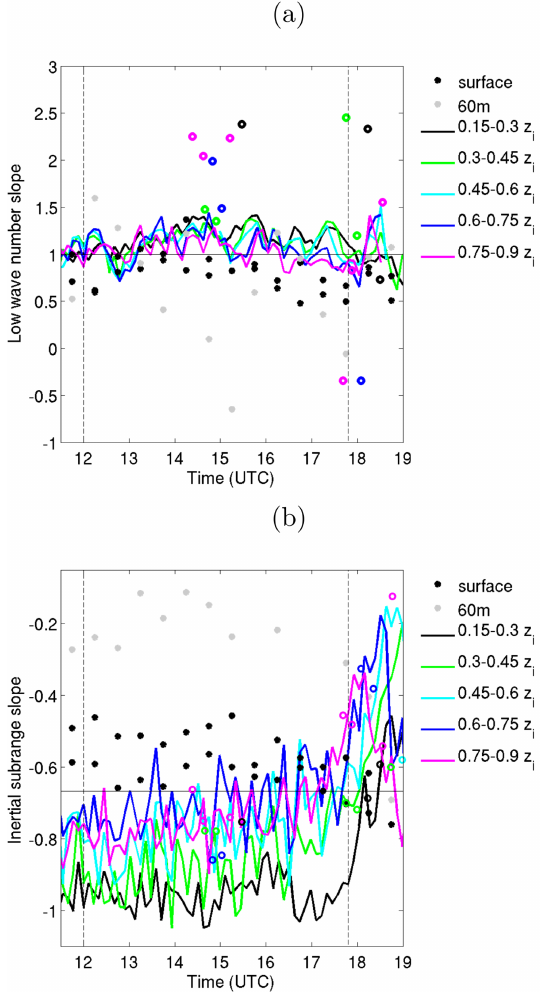
Figure 10. Temporal evolution of the slopes in (a) the low wave number range and (b) the inertial subrange of the w spectra obtained by LES (continuous lines), aircraft and surface measurements (open and filled circles) at different heights (colours). The horizontal black lines stand for the theoretical expected values.